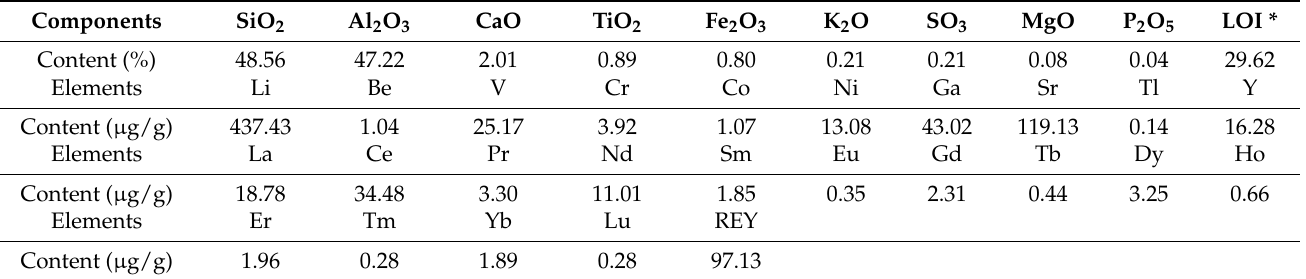
Table 3. The content of major chemical compositions and critical elements in coal gangue